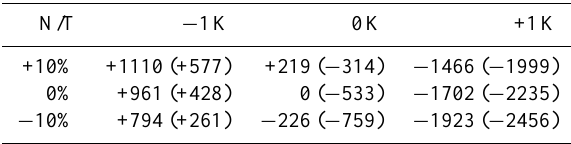
Table 2. Glacier mass balance depending on precipitation and/or air temperature changes. Values stand for mass balance variations in mmw.e. compared to the reference period (2000 until 2006). Values in brackets show the absolute mass